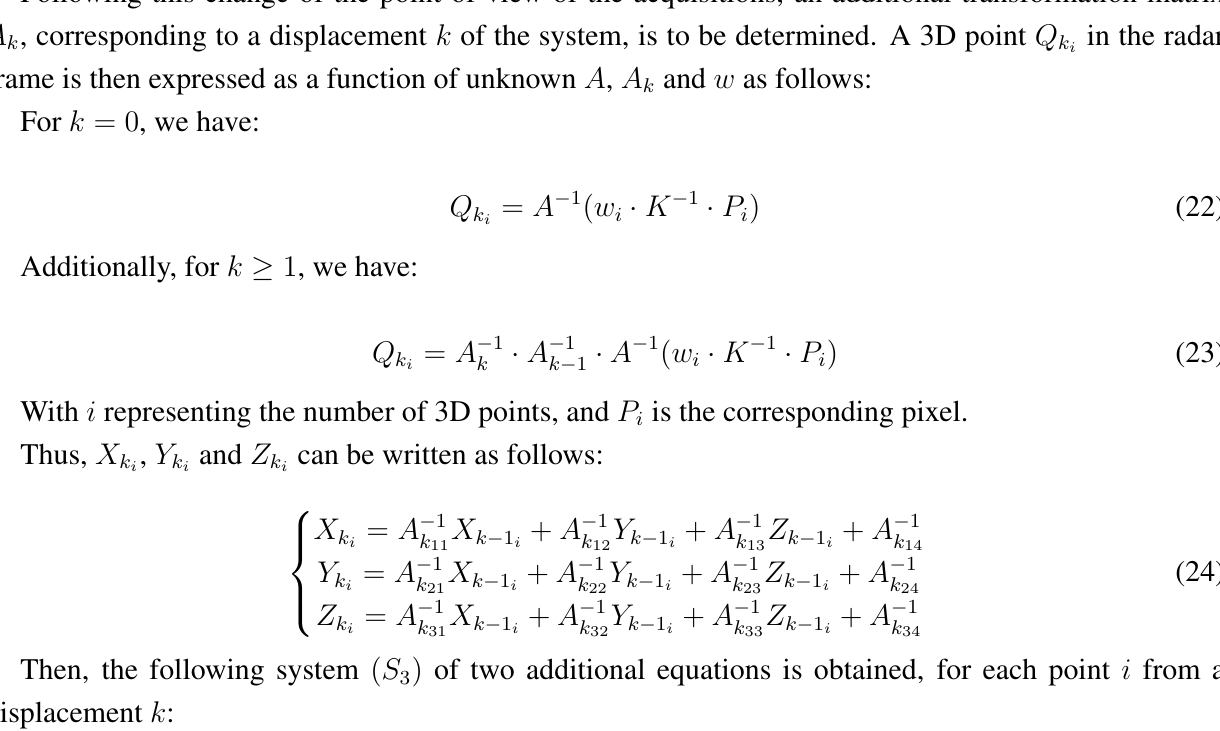
represent the k